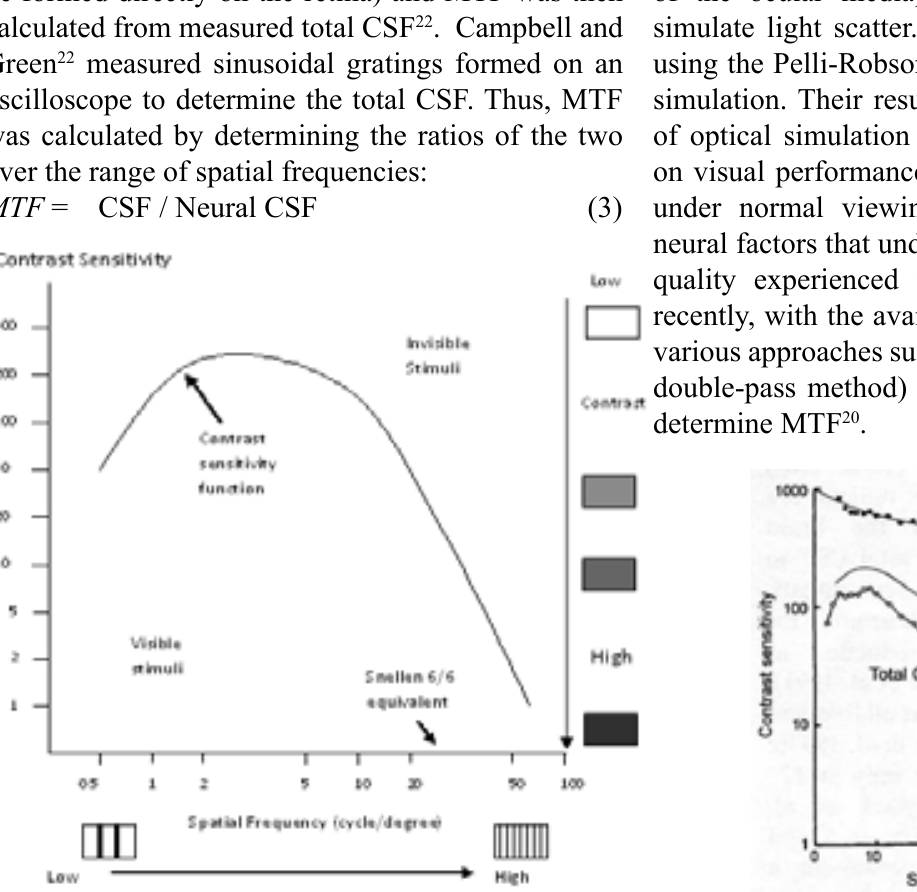
Figure 5 . The calculation of Modulation Transfer Function (MTF) from measured Total Contrast Sensitivity Function (CSF) and measured Neural Contrast Sensitivity Function (Neural CSF) by Campbell and Green. Total CSF was measured using interference fringes and total CSF with sinusoidal gratings. MFT is calculated as the ratio of the two measurements 21 (Figure reproduced with permission from Micheal et al 20 ,